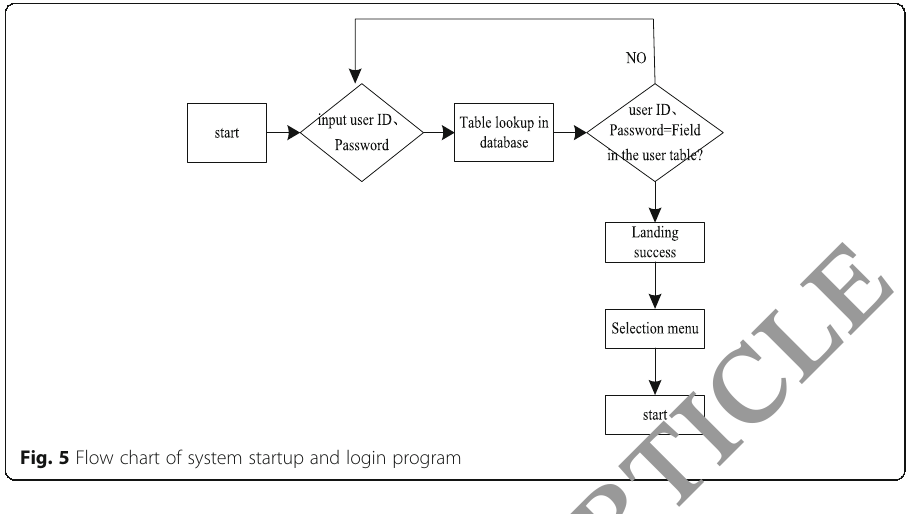
Fig. 5 Flow chart of system startup and login program